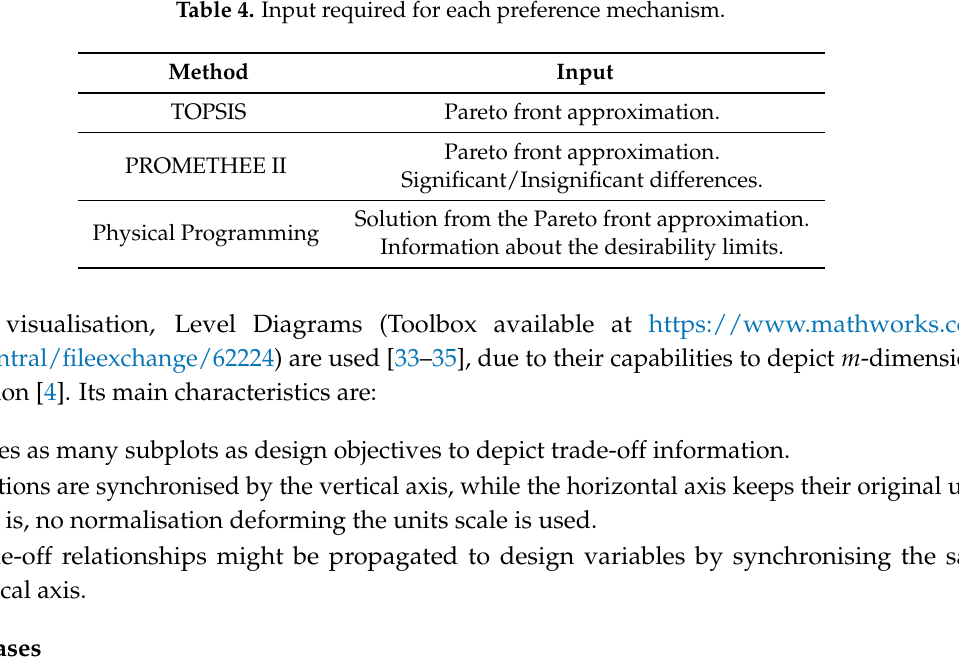
Table 4. Input required for each preference